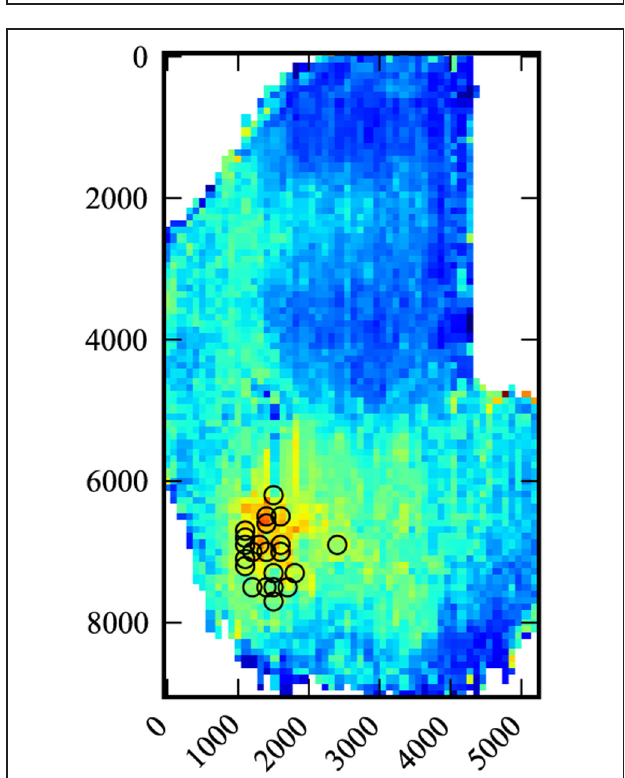
FIGURE 2 | Composite data. Data for all 22 medial injections were compiled and scaled. Black circles indicate injection sites. Number scale is in